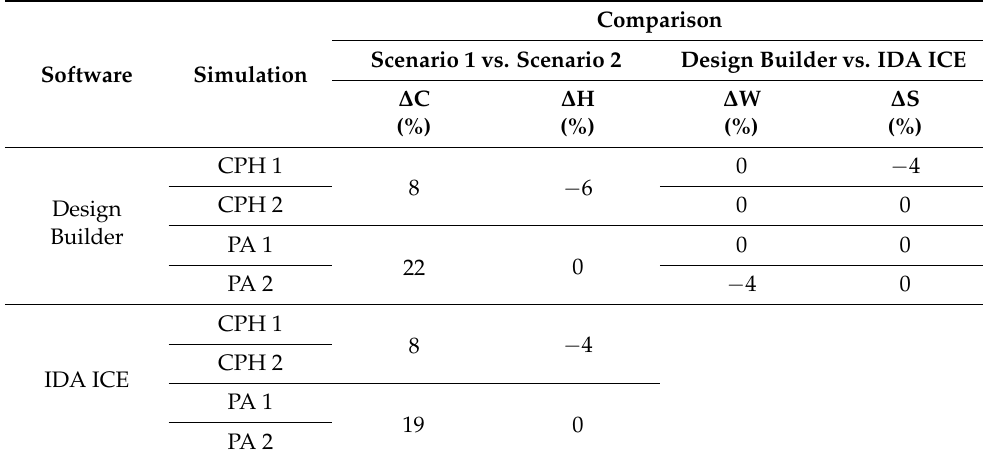
Figure 6. Yearly heating/cooling energy use per square meter predicted by Design Builder (left) and IDA ICE (right). CPH 1: Copenhagen/scenario 1, CPH 2: Copenhagen/scenario 2, PA 1: Palermo/scenario 1, PA 2: Palermo/scenario 2. Table 5. Difference percentage of annual delivered energy ( ∆ C: cooling difference; ∆ H: heating differ- ence) between scenario 1 (small window) and 2 (large window), calculated with Equations (10) and (11), and between Design Builder and IDA ICE, calculated with Equations (13) and (14).